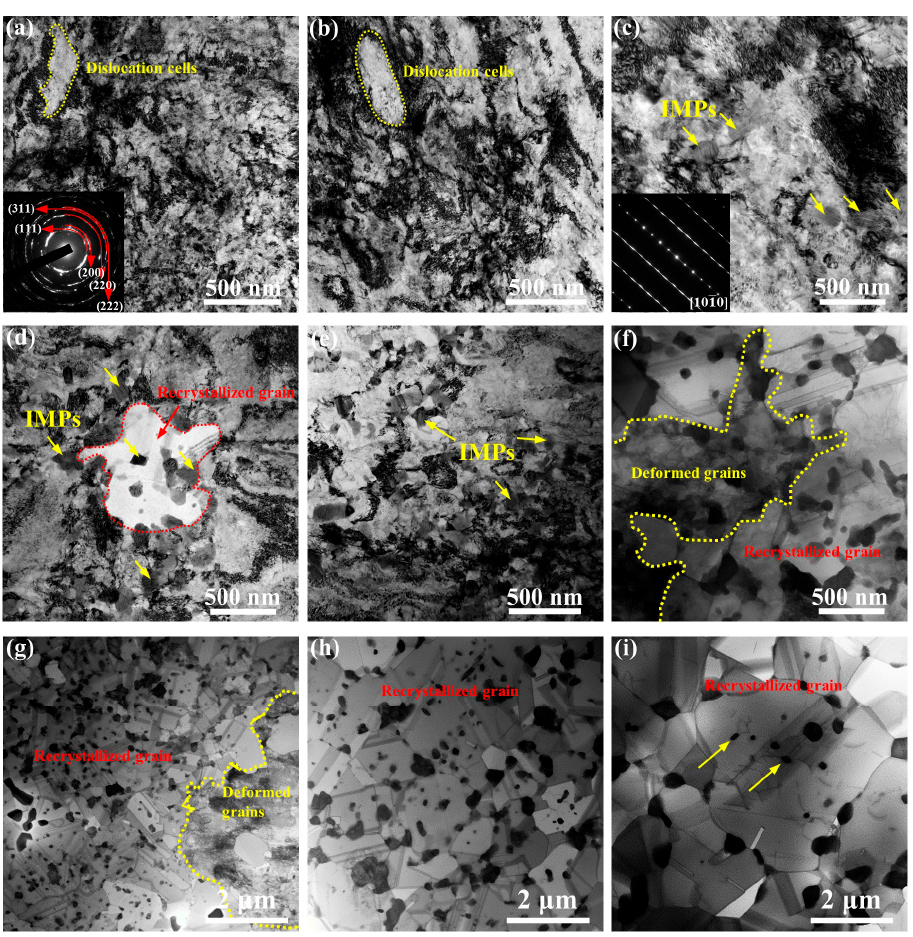
Figure 1. The microstructural evolution of the Mo 10 HEA: ( a ) CR sample; ( b ) 650 °C − annealed sample; ( c , d ) 700 °C − annealed sample; ( e ) 750 °C − annealed sample; ( f ) 800 °C − annealed sample; ( g ) 850 °C − annealed sample; ( h ) 900 °C − annealed sample; ( i ) 1000 °C − annealed sample.